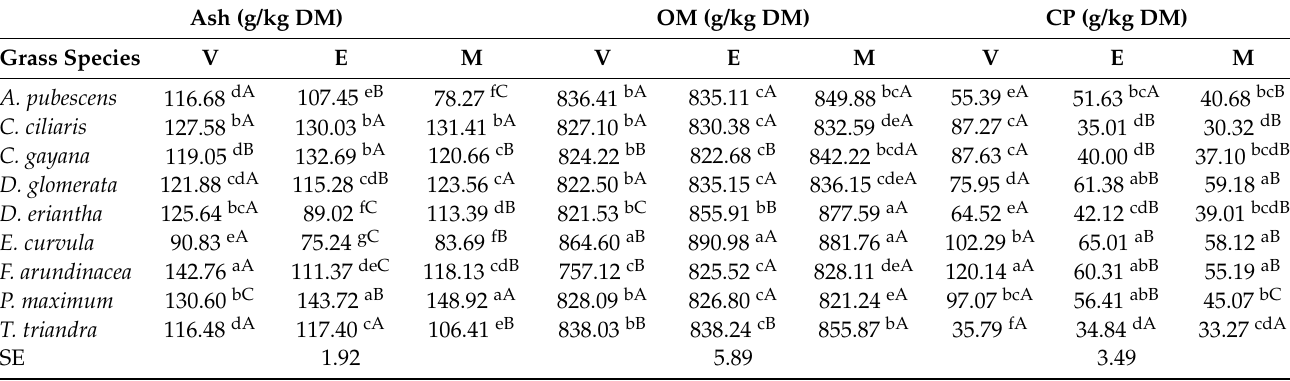
Table 3. Effect of species and growth stage on ash, organic matter (OM) and crude protein (CP) (DM in g/kg) in nine selected grass species grown under controlled conditions.